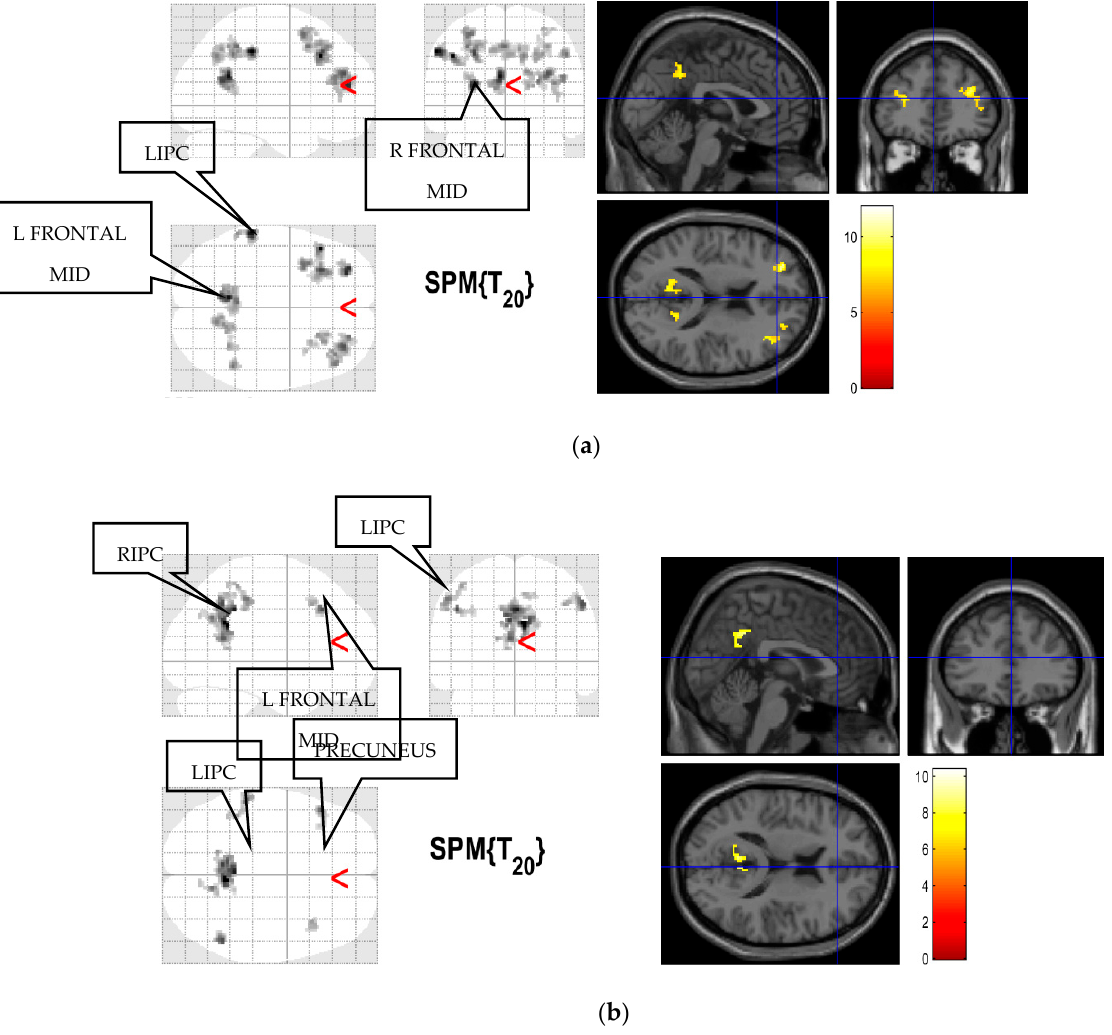
Figure 5. Group result of the brain functional connectivity in DMN obtained from ( a ) 10 and ( b ) 15 min scanning times from 21 healthy subjects ( p FWE = 0.05, k E = 20). A red line arrow head (<) indicate the point of maximum intensity with of the brain activation in each group. Color scales reflect T values of one-sample t test.